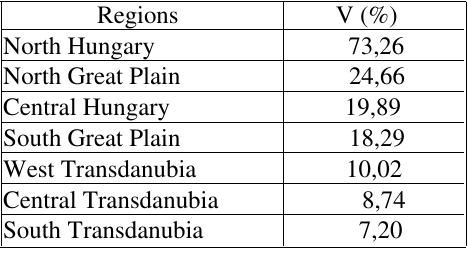
Table 4: Relative deviation of sour cherry production per region Regions